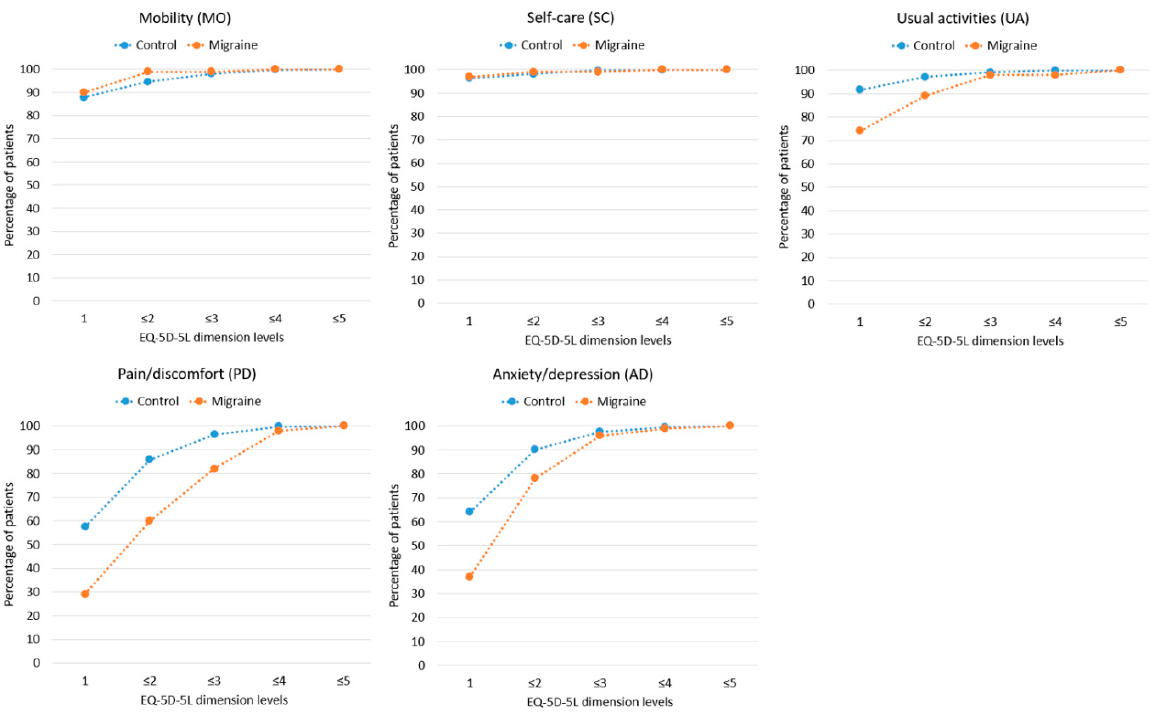
Figure 1. EQ-5D-5L dimensions in patients with migraine (N = 100) compared to control from the general population (N = 100; dashed lines are means of graphical visualization).